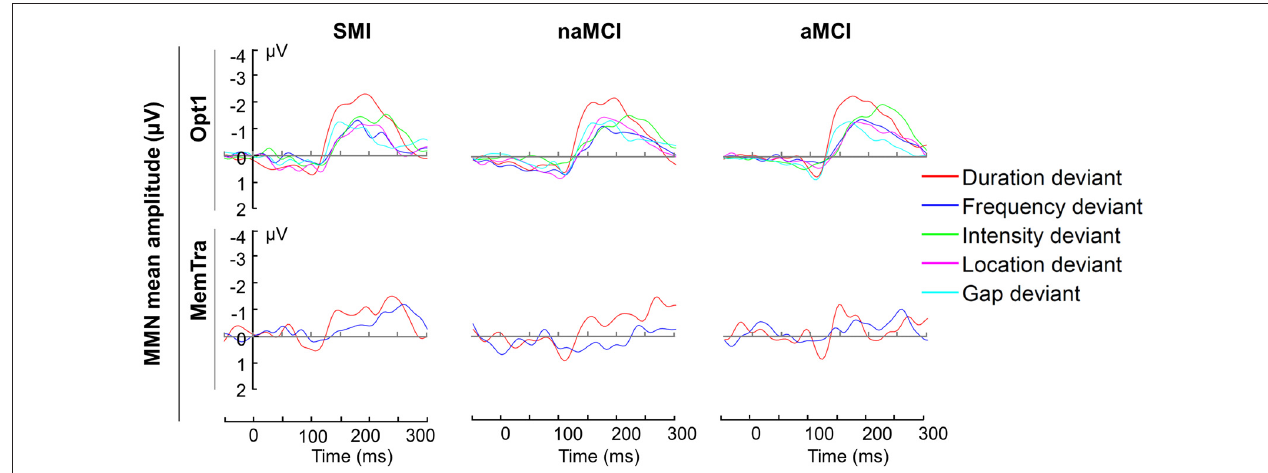
FIGURE 2 | Mean MMN amplitudes for the Opt1 paradigm and MemTra paradigm within groups. Mean values are the averaged signal of the fronto-central electrodes Fz, FCz, and Cz. Opt1, Optimum–1; MemTra, Memory Trace; aMCI, amnestic MCI; naMCI, non-amnestic MCI; SMI, subjective memory impairment.